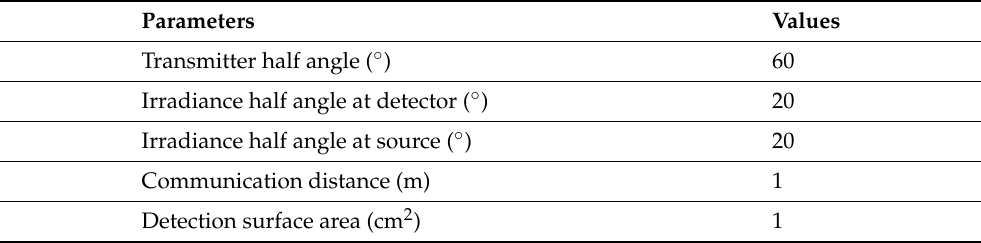
Table 1. The simulation